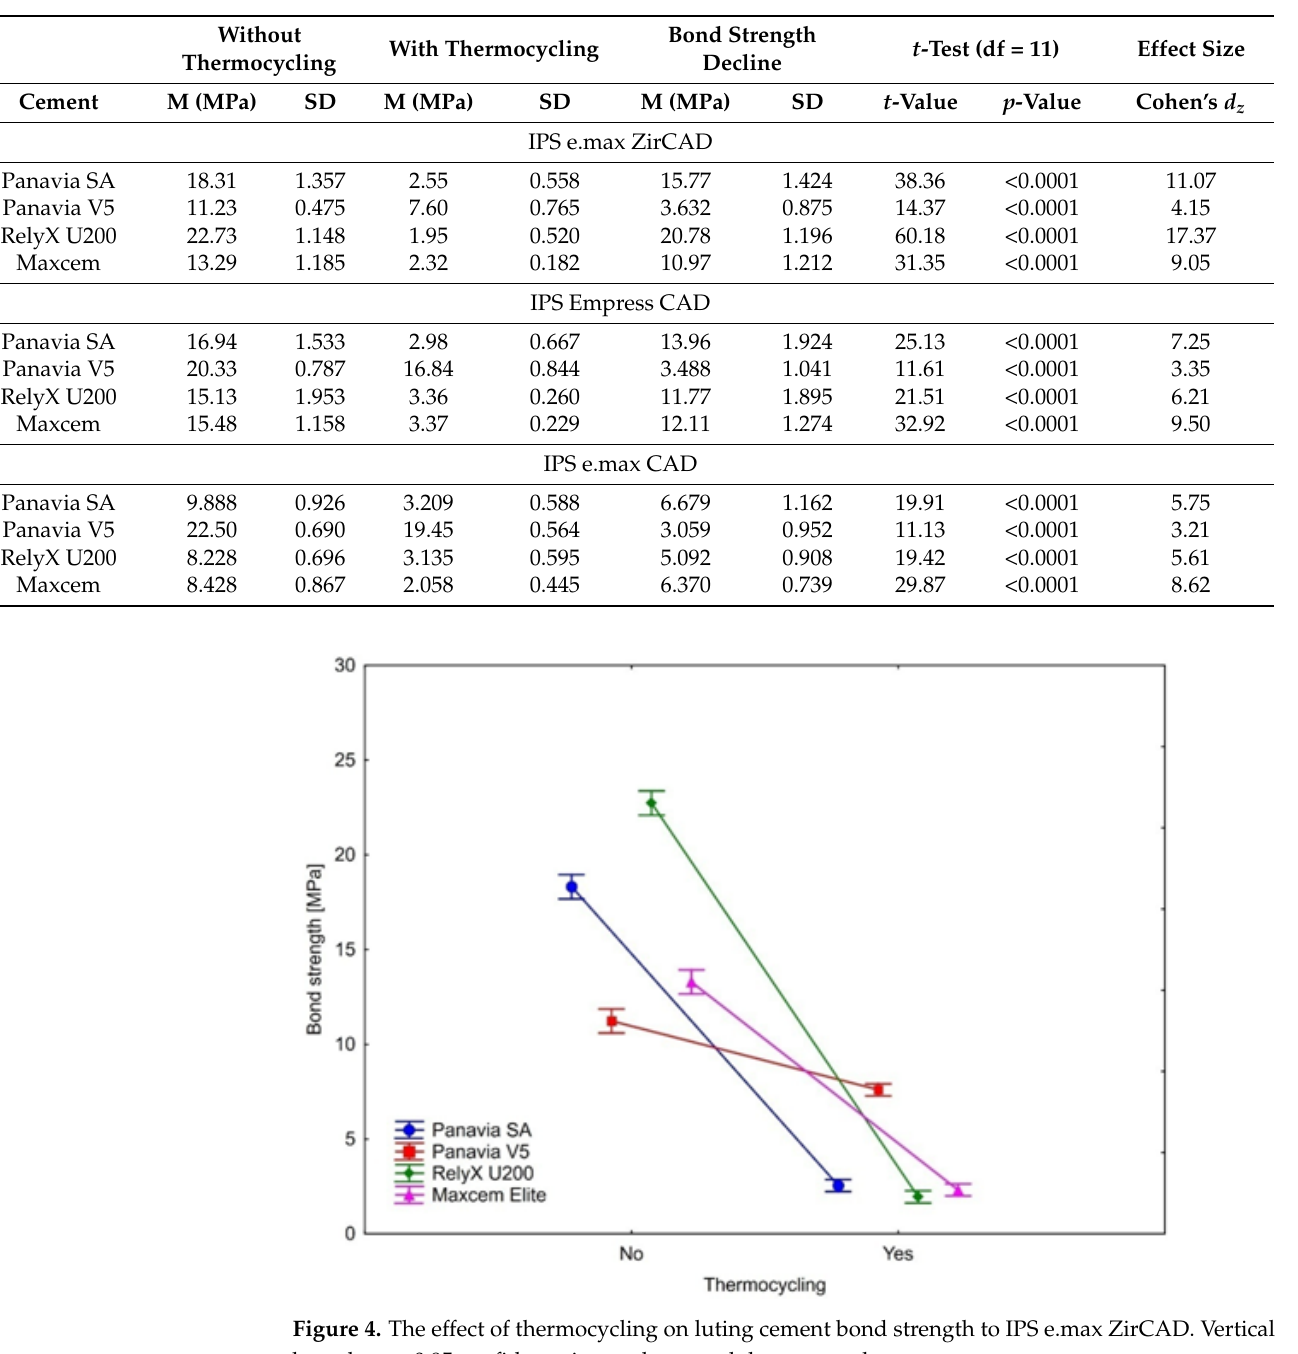
Figure 5. The effect of thermocycling on luting cements bond strength to IPS Empress CAD. Verti ‐ cal bars denote 0.95 confidence intervals around the mean values.